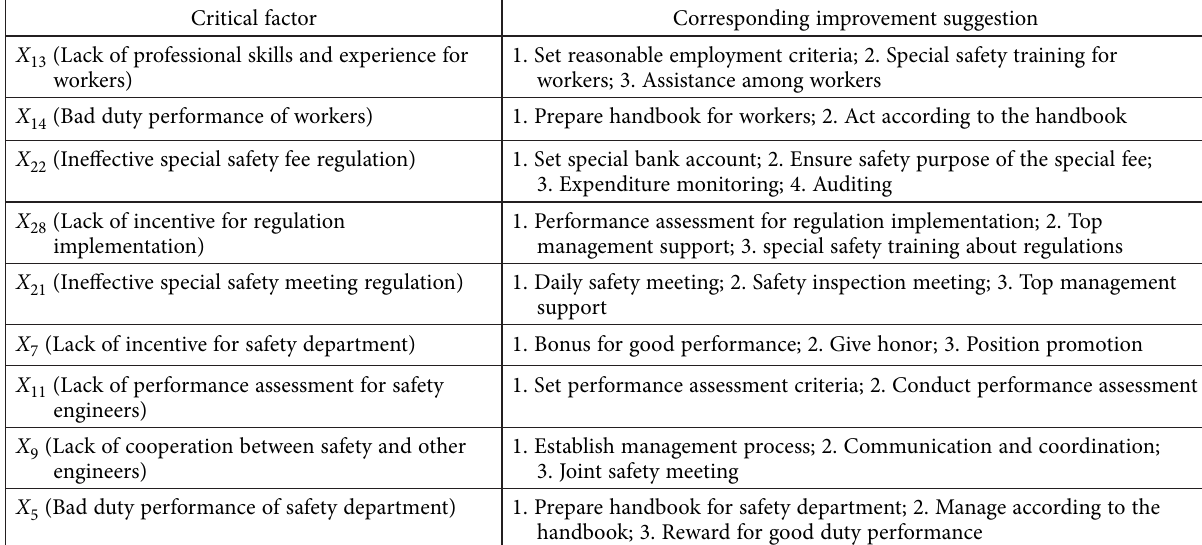
Table 8. Critical factors and corresponding improvement suggestions Critical